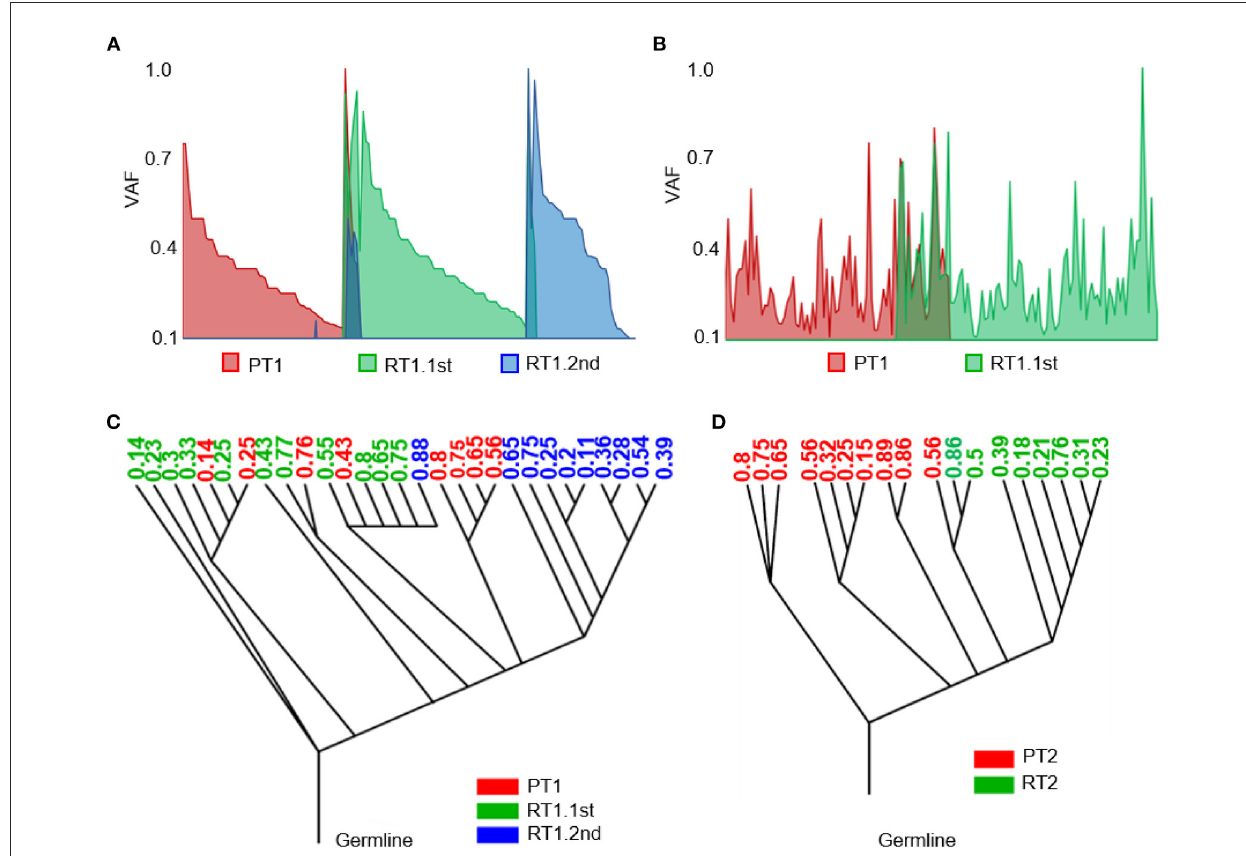
FIGURE5 Heterogeneity of the sub-frontal recurrent MBs was driven by clonal selection. (A, B) Switch of somatic mutations showed evolutionary plasticity of sub-frontal recurrent MBs. (C, D) Phylogenetic relationships among primary (red), first recurrent (green), and second recurrent (blue) tumors showed that the recurrence might have been derived from a single primary tumor lineage (RT2) or had an intermediate phylogenetic similarity to matched primary one (RT1.1st). The number means the cellular prevalence values of each